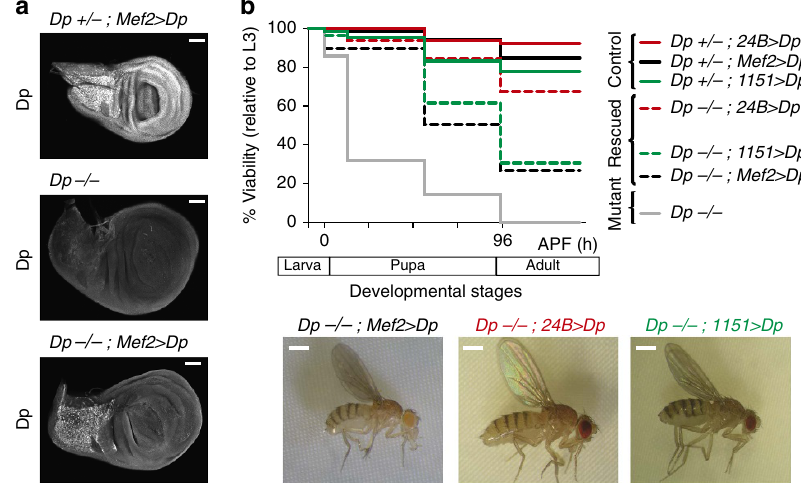
Figure 2 | Expression of Dp in adult skeletal muscles rescues the lethality of the whole-body Dp (cid:2) / (cid:2) null mutant animals. ( a ) Confocal sections of the adepithelial cells show that Dp expression is restricted to the adult myoblasts of the rescued animals ( Dp a3 /Df(2R)Exel7124;Mef2-GAL4/UAS-Dp , bottom panel), compared with the Dp -mutant ( Dp a3 / Df(2R)Exel7124 , middle panel), and control ( Dp a3 / þ ;Mef2-GAL4/UAS-Dp , top panel). Representative images are shown. Scale bar, 0.5 m m. ( b ) The number of viable flies was quantified throughout development. Dp mutants, Dp a3 / Df(2R)Exel7124 (grey line, n ¼ 445), are lethal at mid-pupa stage. The lethality is partially rescued by overexpressing UAS-Dp in the muscle using either Mef2-GAL4 (black dotted line, n ¼ 204 flies), 24B-GAL4 (red dotted line, n ¼ 65 flies) or 1151-GAL4 (green dotted line, n ¼ 72 flies). Control genotypes are Dp a3 / þ ; Mef2-GAL4/UAS-Dp (black solid line, n ¼ 337 flies), Dp a3 / þ ;24B-GAL4/UAS-Dp (red solid line, n ¼ 66 flies) and 1151-GAL4;Dp a3 / þ ;UAS-Dp (green solid line, n ¼ 113 flies). At least two independent experiments were performed using at least six replicates per genotype each. The genotypes Dp a3 /Df(2R)Exel7124;Mef2-GAL4/UAS-Dp , Dp a3 /Df(2R)Exel7124;1151-GAL4/UAS-Dp , and their respective controls were confirmed by single-fly PCR and by sequencing the Dp -mutant allele in